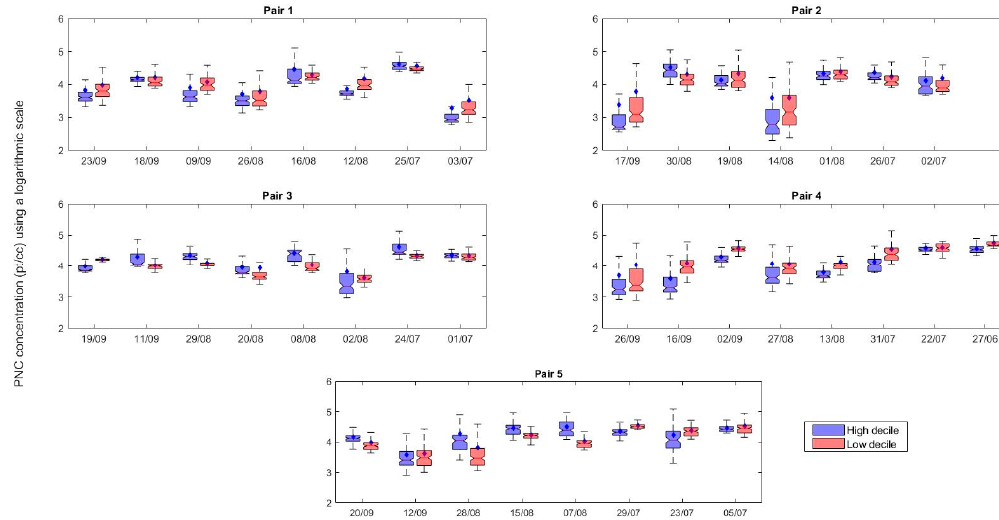
Figure 7. Boxplot of log transformation of measured PNC along the whole routes for each pair of schools. The blue boxes indicate the high decile schools and red boxes indicate the low decile schools.